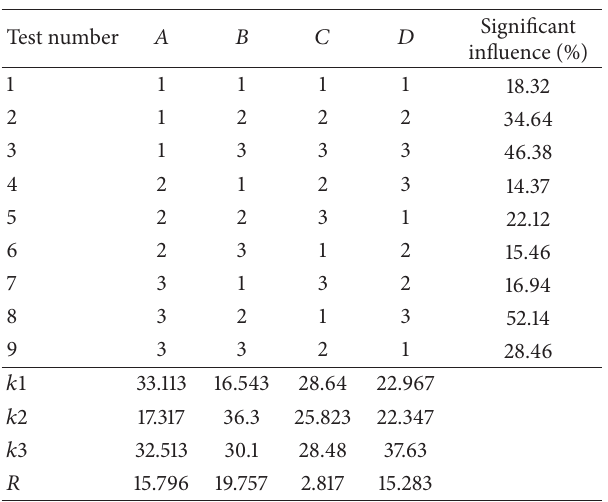
Table 2: Orthogonal experiment result of matrine